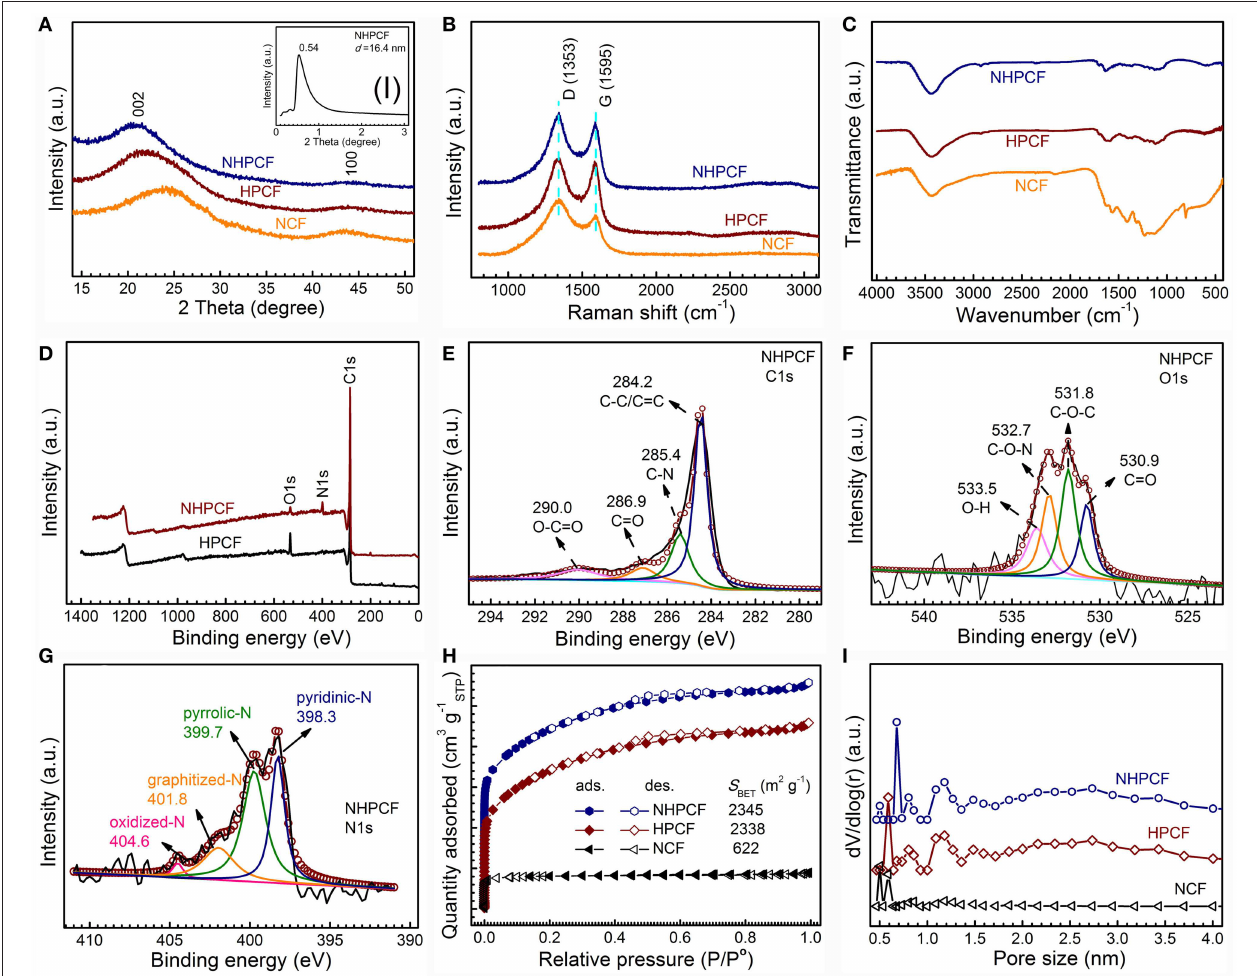
FIGURE 2 | (A) XRD patterns of NCF, HPCF, and NHPCF (inset shows small angle XRD of NHPCF), (B) Raman spectra, (C) FT-IR spectra of NCF, HPCF, and NHPCF, (D) XPS survey spectra of HPCF, and NHPCF, (E–G) C1s spectra, O1s spectra, and N1s spectra of NHPCF, (H) Nitrogen adsorption-desorption isotherms and (I) pore size distributions calculated by NLDFT method of NCF, HPCF, and NHPCF.